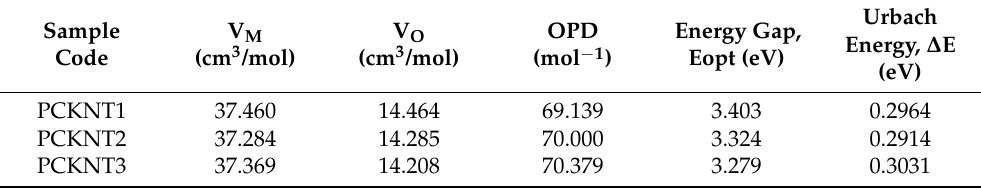
Table 2. The molar volume (V M ), oxygen molar volume (V O ), optical packing density (OPD), energy gap (Eopt), and Urbach energy ( ∆ E) of the prepared